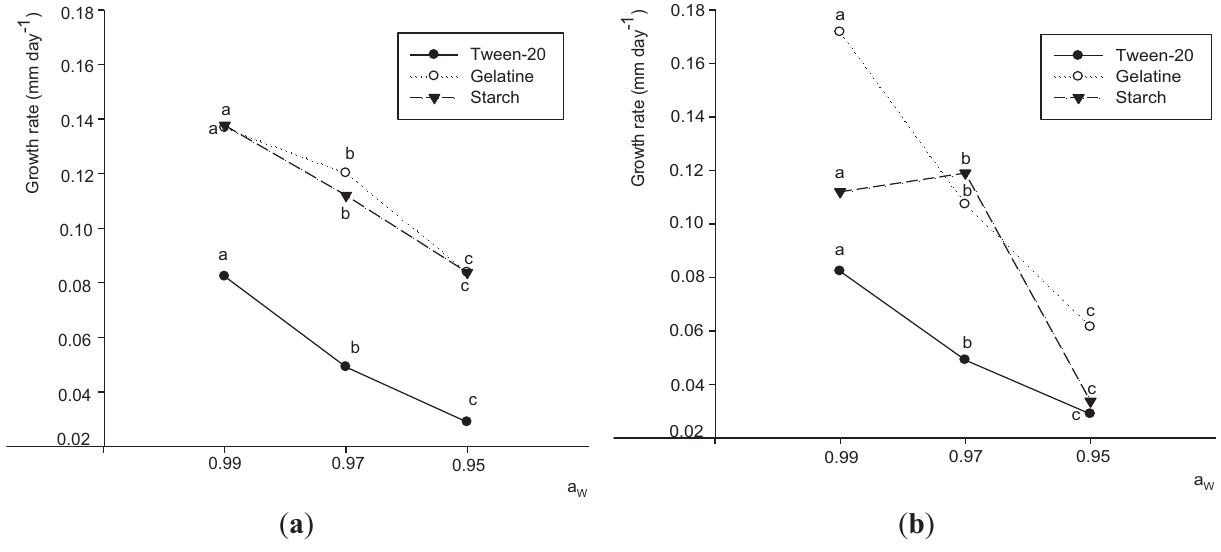
Figure 2. Comparison of growth rates of P. lilacinum JQ926212 ( a ) and JQ926223 ( b ) with different substrates: : tween-20; : gelatine and : starch at different water activities. Data with different letters for the same substrate at different Aw are